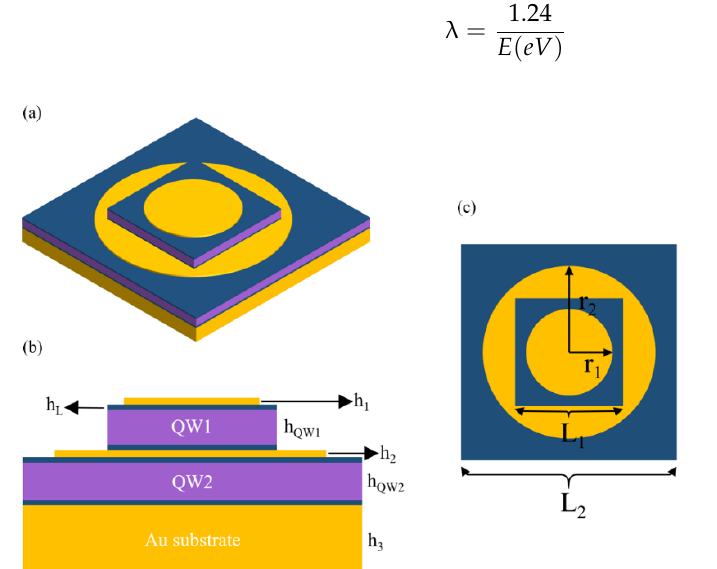
Figure 1. Schematic diagram of double-band stacked quantum well infrared photodetector structure: ( a ) the three-dimensional view, ( b ) the unit cell from the x-z plane view; ( c ) the top view.